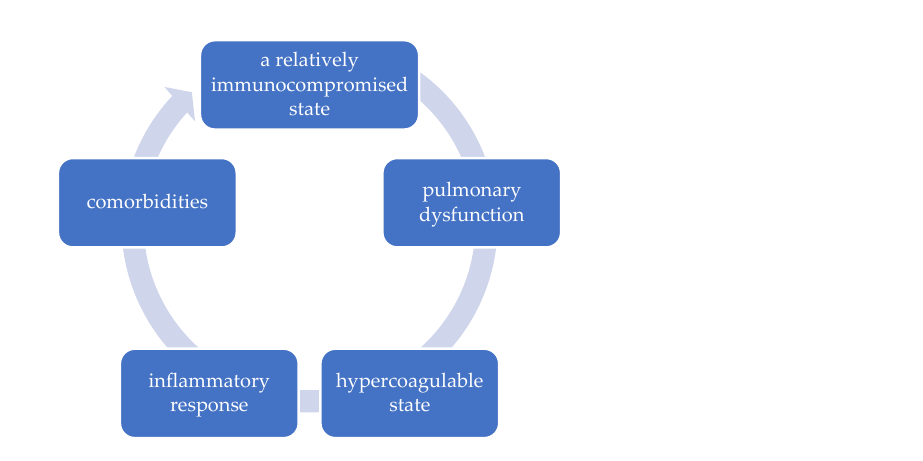
Figure 1. The vicious circle of etiopathogenic factors in pregnant women with COVID-19.